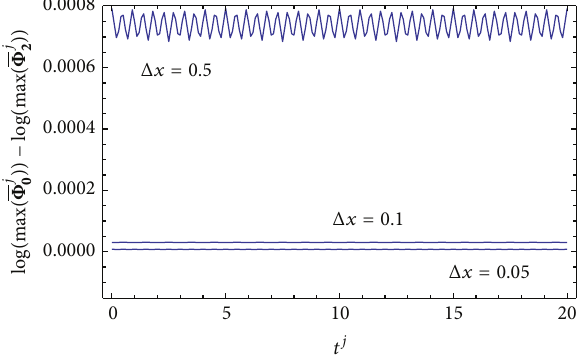
𝑗 )− log ( max Φ 𝑗 ) 0 2